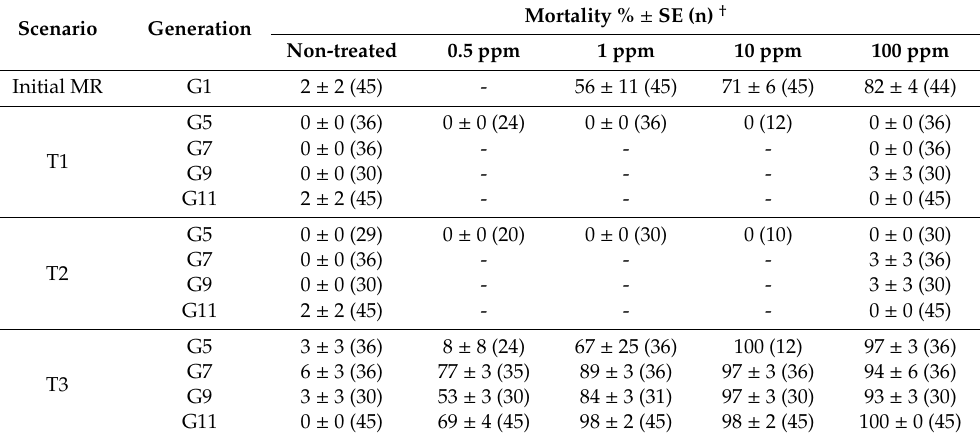
Table 5. Susceptibility to spinosad of the multi-resistant strain MR of Ceratitis capitata under three di ff erent scenarios of insecticide treatments, T1: alternation of spinosad for three generations and lambda-cyhalothrin for one generation; T2: alternation of spinosad for two generations and lambda-cyhalothrin for two generations; T3: non-treated. See Figure 1 for more